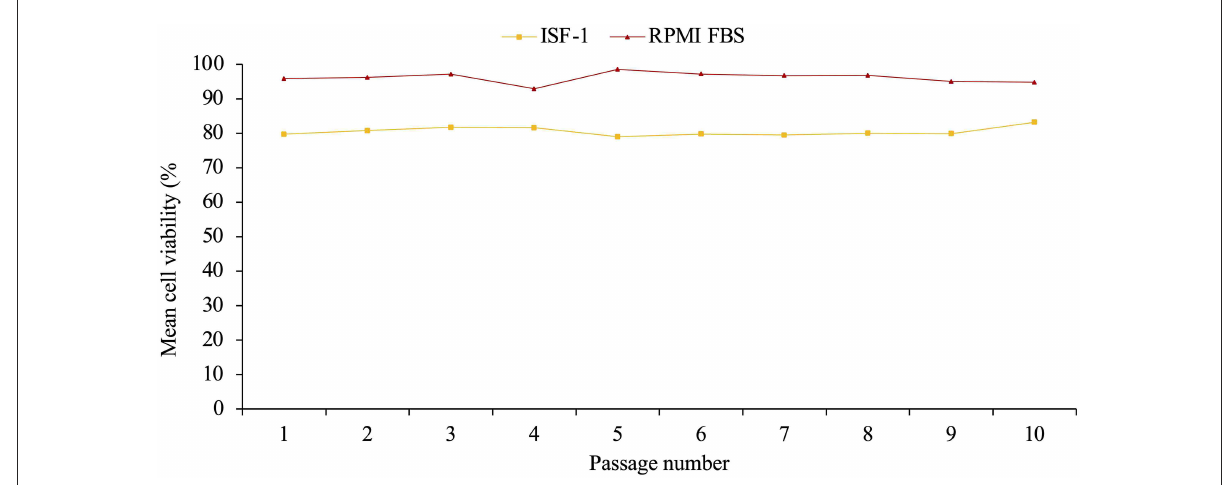
FIGURE6 Mean cell viability of resuscitated Ankara cell line culture propagated in ISF-1 and RPMI supplemented with 10% fetal bovine serum